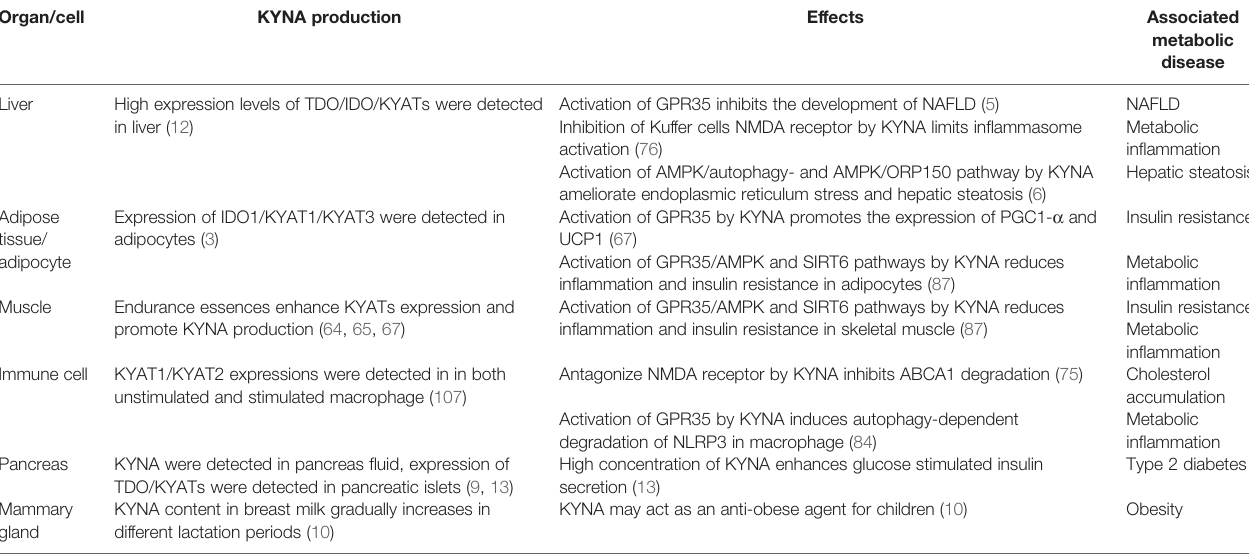
TABLE 3 | The roles of KYNA in metabolic